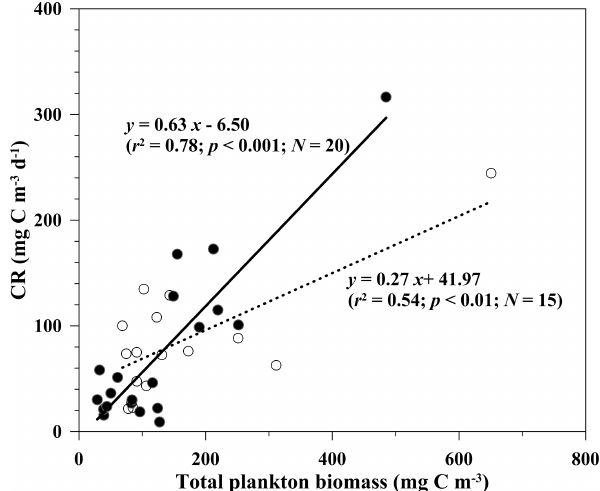
Figure 5. Relationship between plankton community respiration (CR) and total plankton biomass (expressed per carbon unit) over the Z E in 2009 ( ◦ ; solid line) and 2010 ( • ; dashed line). The re- spective r 2 and p values are shown for each linear regression line. The total plankton biomass is the summed biomass of phytoplank- ton, bacterioplankton, and zooplankton. Please refer to the “Mate- rials and Methods” section for details on the carbon conversion for plankton communities.